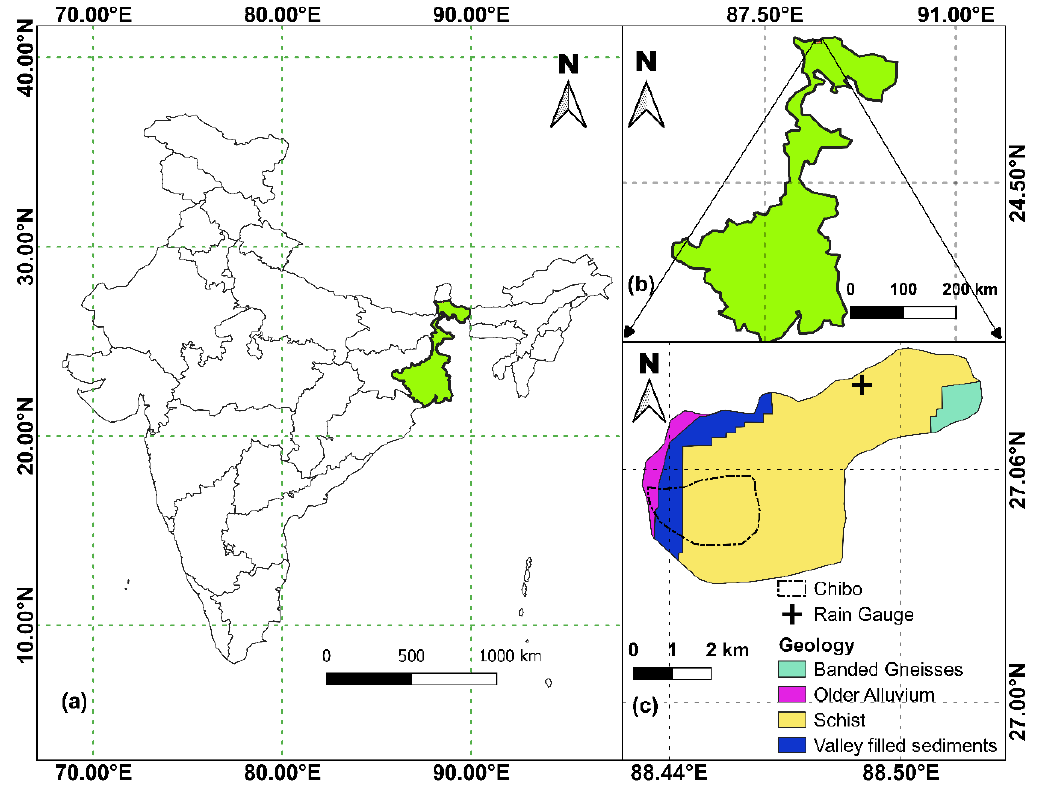
Figure 1. Location details of study area ( a ) India, ( b ) West Bengal and ( c ) Geological map of Kalimpong town (Modified after [22]).